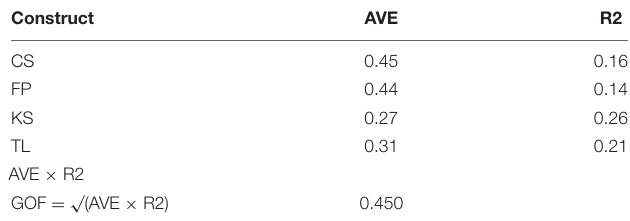
TABLE 5 | Structural model assessment (direct effect results and decision).